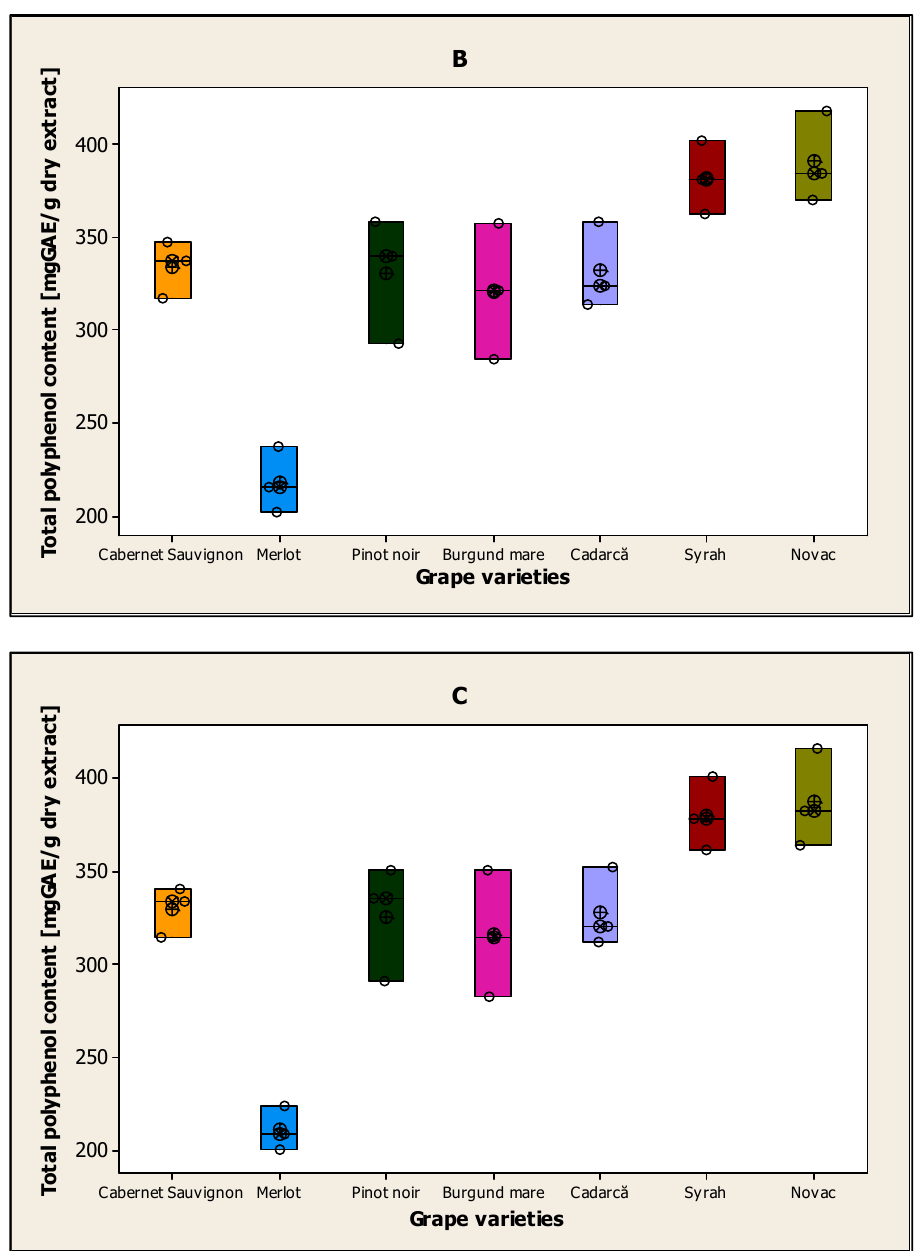
Figure 1. ( A ) The total polyphenol content determined from the seeds of the seven grape varieties on the first day; ( B ) the total polyphenol content determined from the seeds of the seven grape varieties on the 14th day; ( C ) the total polyphenol content determined from the seeds of the seven grape varieties on the 30th day .